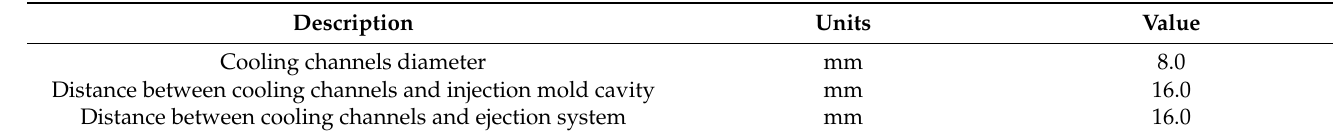
Table 5. Geometric variables of the traditional cooling system design.